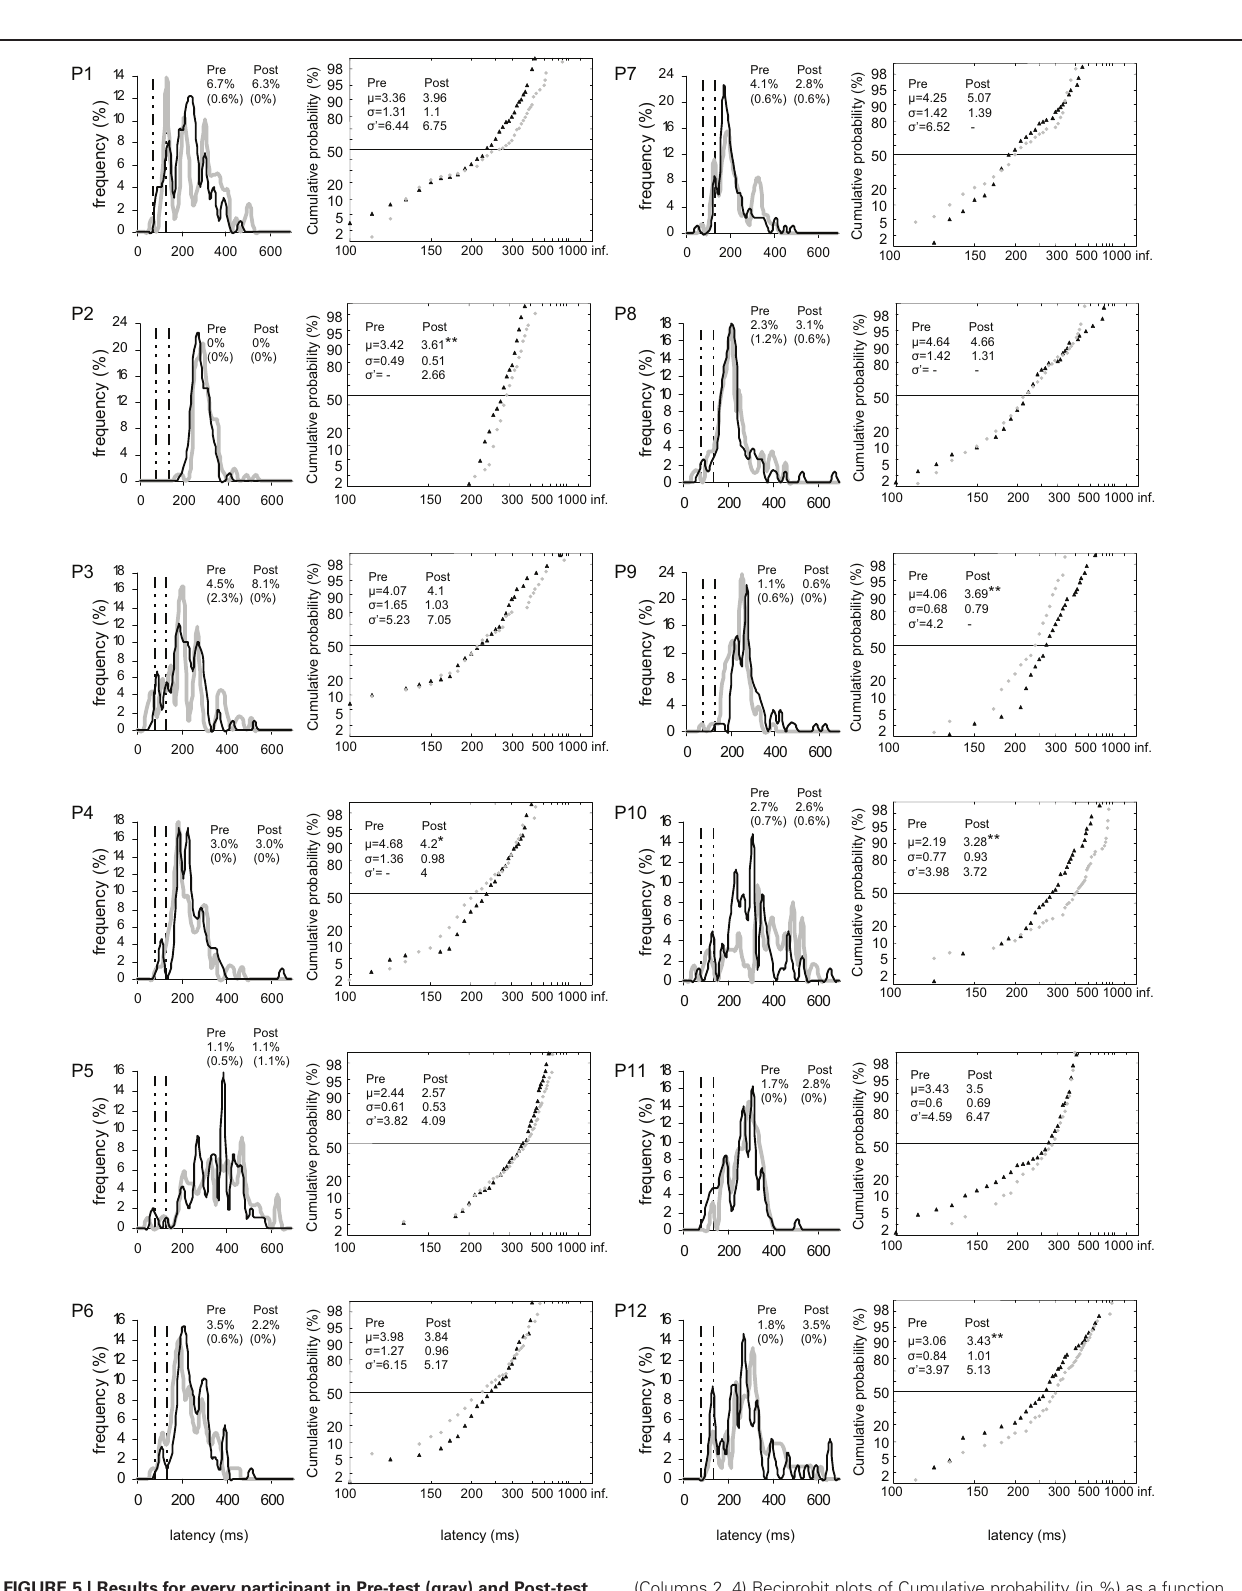
(Columns 2, 4) Reciprobit plots of Cumulative probability (in %) as a function of Latency (in ms) for saccades between 80 and 999ms in valid direction, and μ , σ , and σ (cid:4) values. N = 63–106 in frequency histograms; N = 62–106 in reciprobit plots. Other notations as in Figure 3